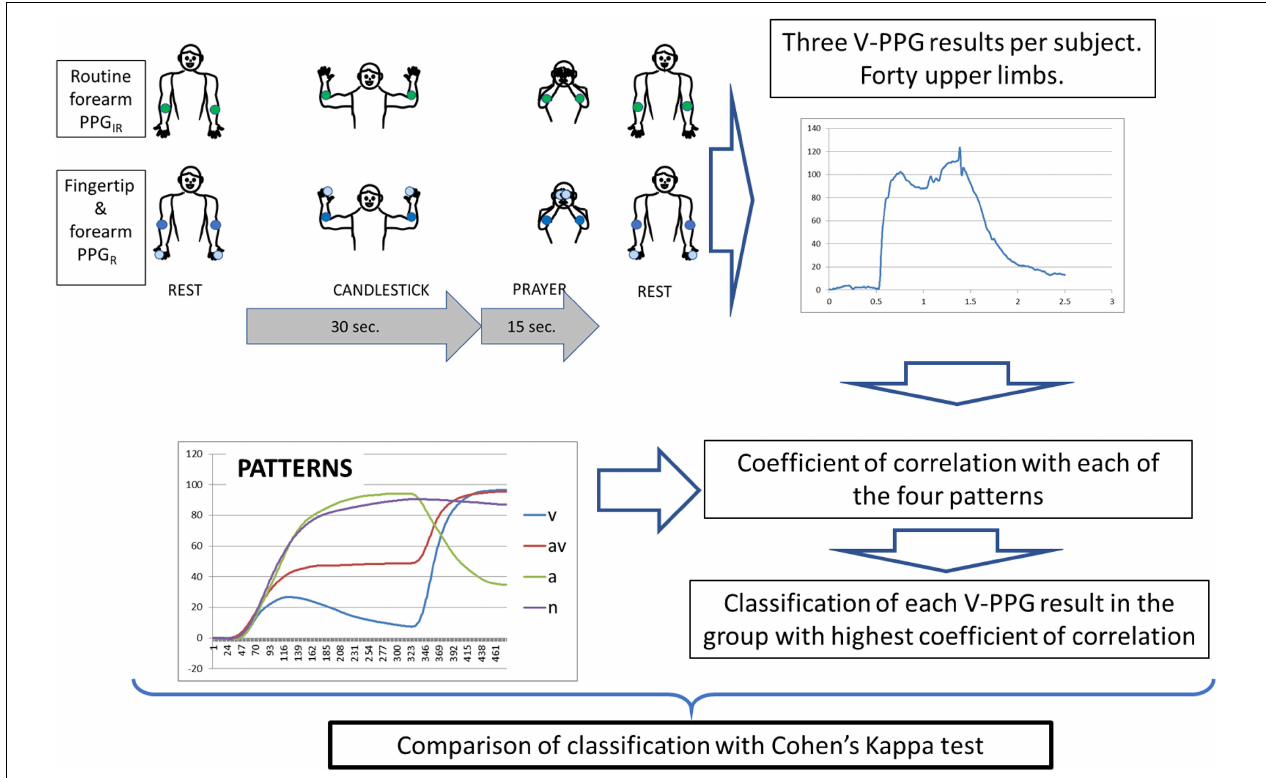
FIGURE 1 | Schematic representation of the methods.